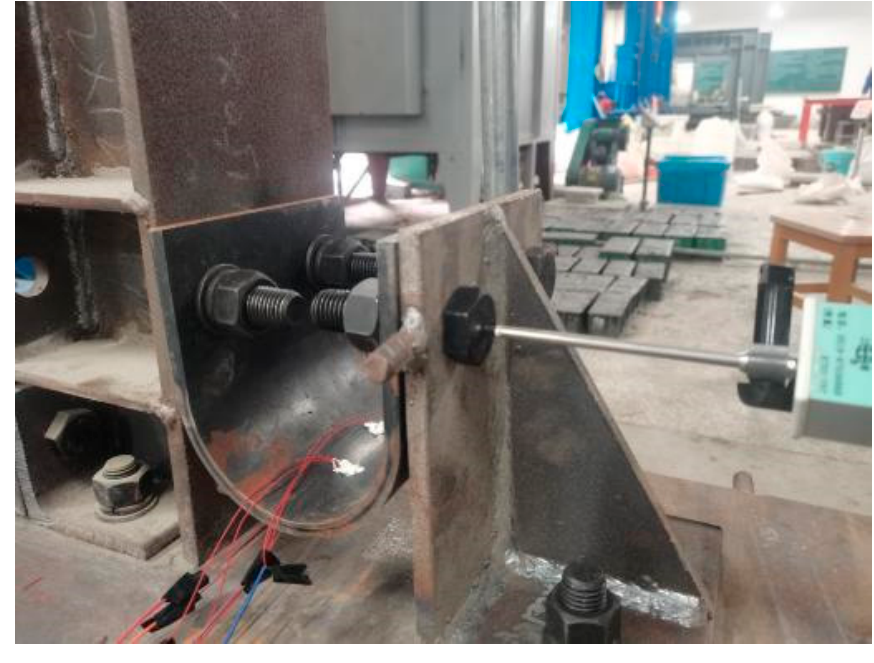
Figure 4. Detailed drawing.